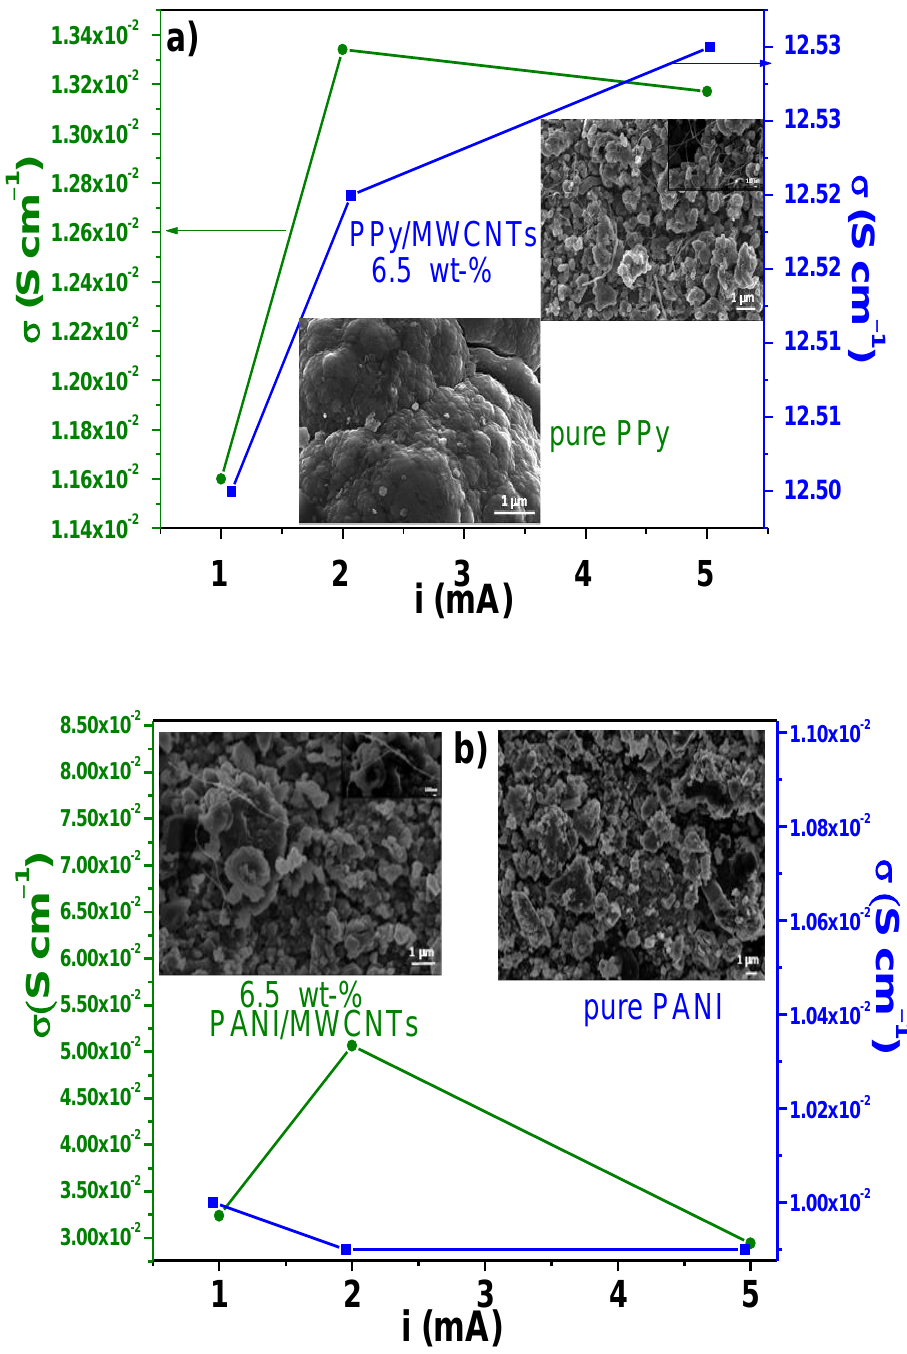
Figure 10. Variation of electrical conductivity performance of ( a ) PPy/MWCNT and ( b ) PANI/MWCNT composites at different applied currents.